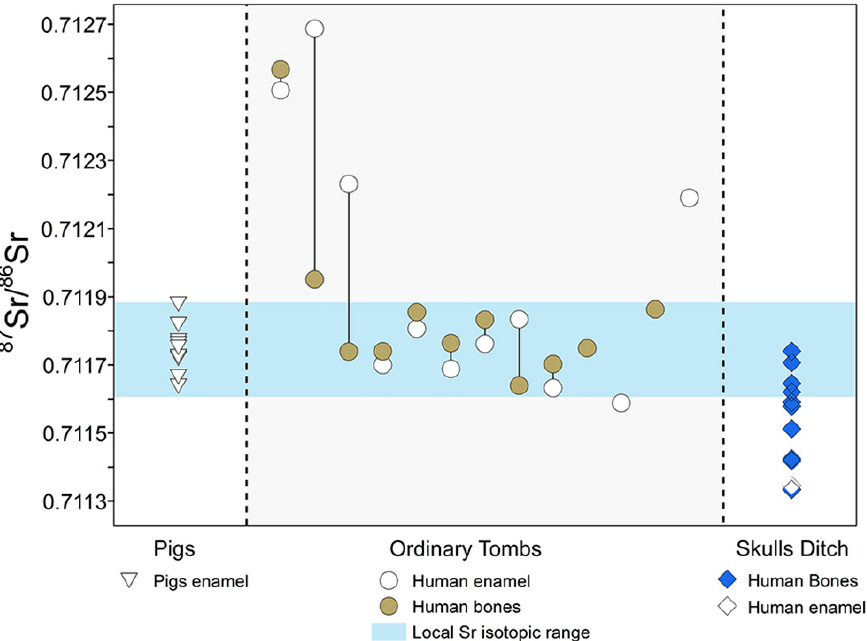
Figure 3. Human and animal 87 Sr/ 86 Sr values from Zhengzhou Shang City (the black line connecting the human enamel and bone samples represents the same individual). the human enamel and bone samples represents the same